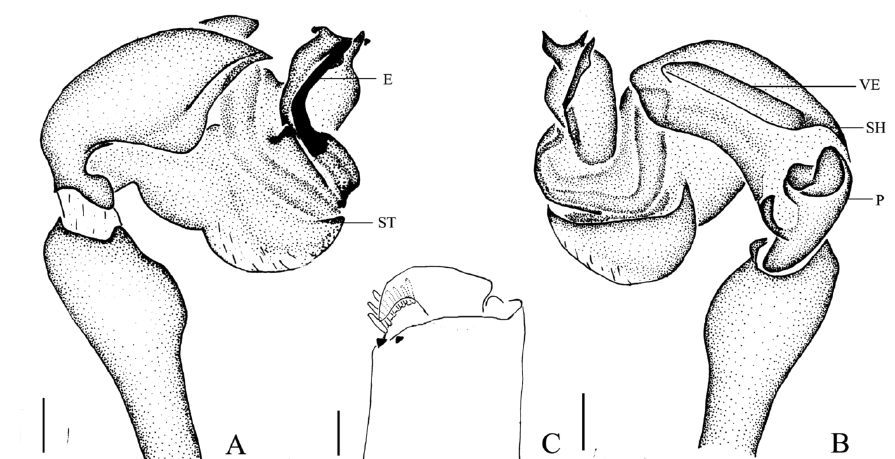
Figure 6. Mimetus lamellaris sp. n., holotype male. A palp, prolateral view B palp, retrolateral view C left chelicerae, ventral view. Scale bars: A–C ,